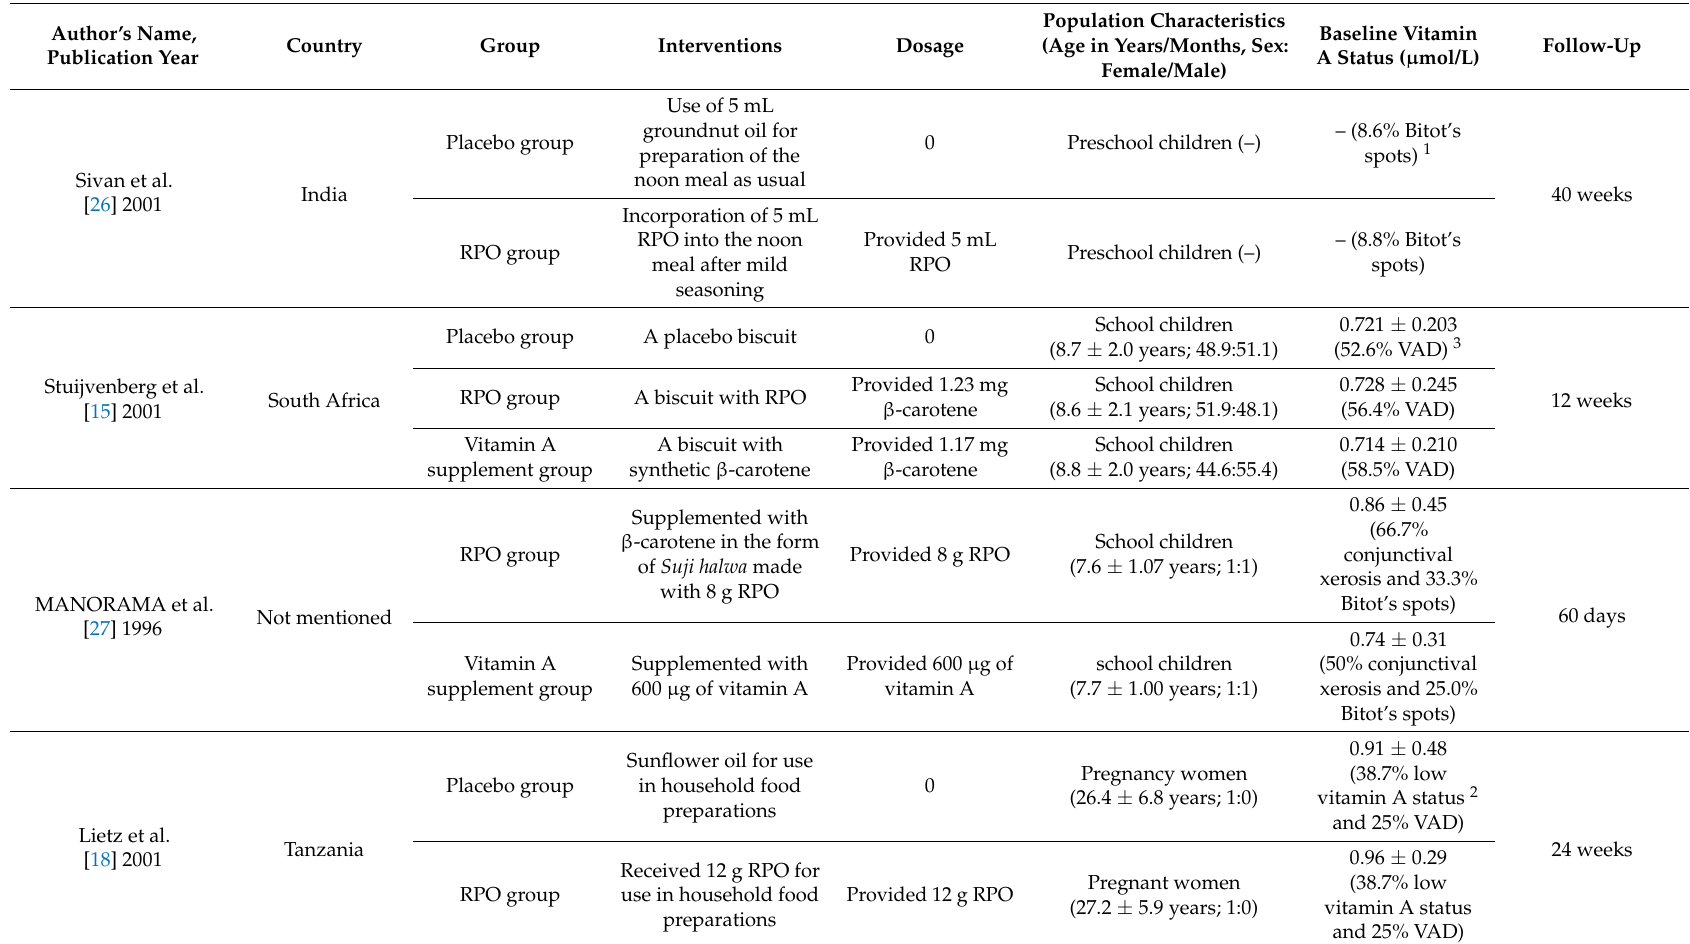
Table 1. Characteristics of available eligible